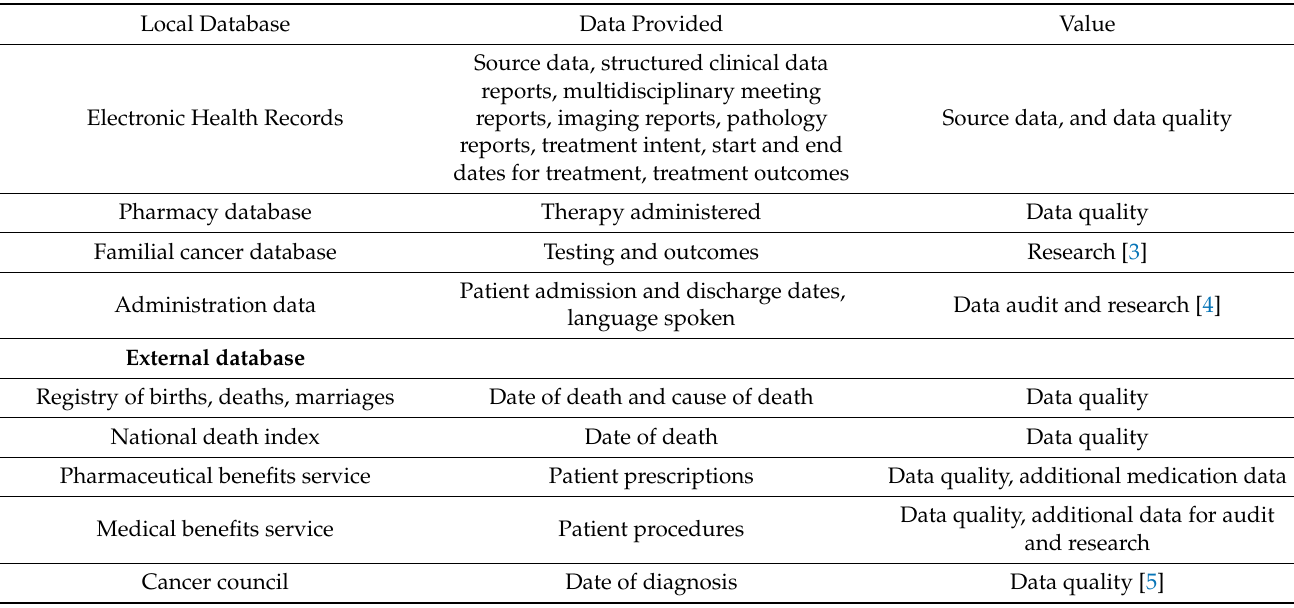
Table 1. Examples of data linkage and value